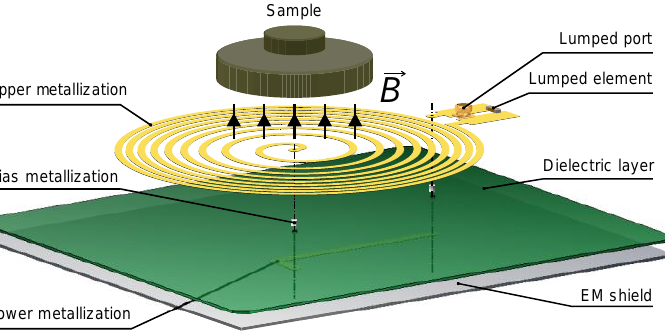
Figure 1. Geometric model of a spiral coil. General view with excitation port and resonant circuit capacitor.